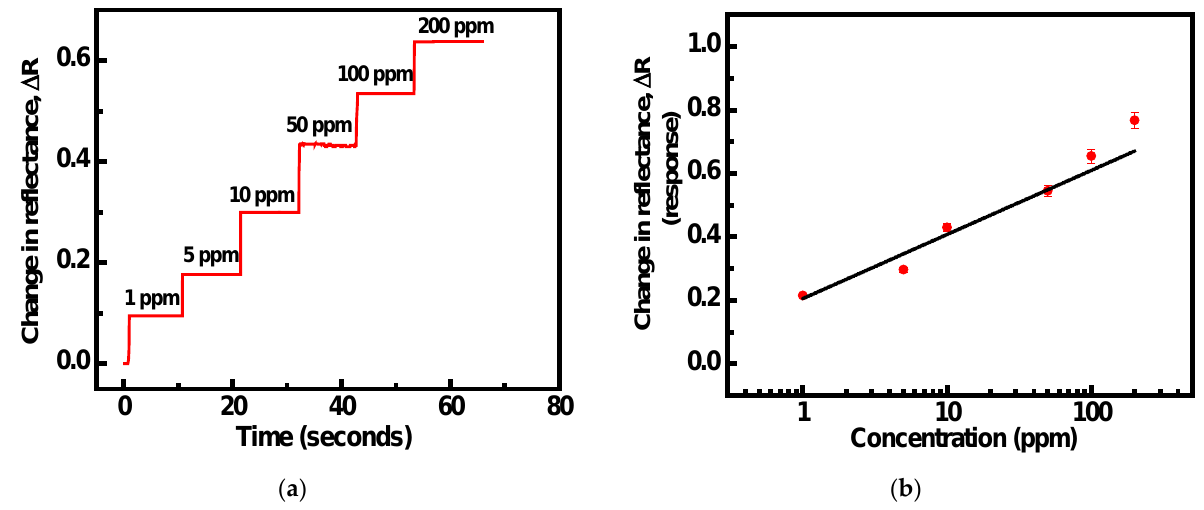
Figure 8. ( a ) Transient response of SPR sensor (prism + Au + SnO 2 + PPy) system, ( b ) the calibration curve of the SPR sensor towards NH 3 gas, and linear variation of change in reflectance with increasing concentration of NH 3 gas.